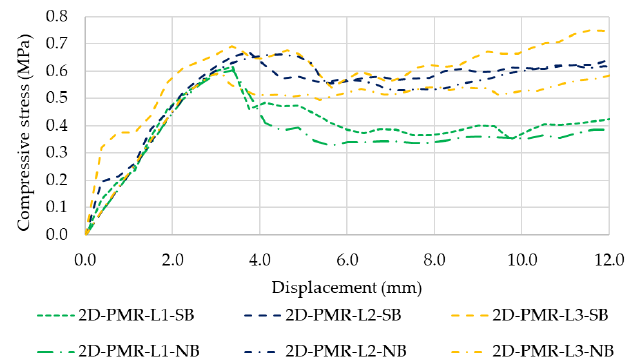
Figure 14. Stress–displacement diagrams for the 2D-PMR models: strong bond versus no